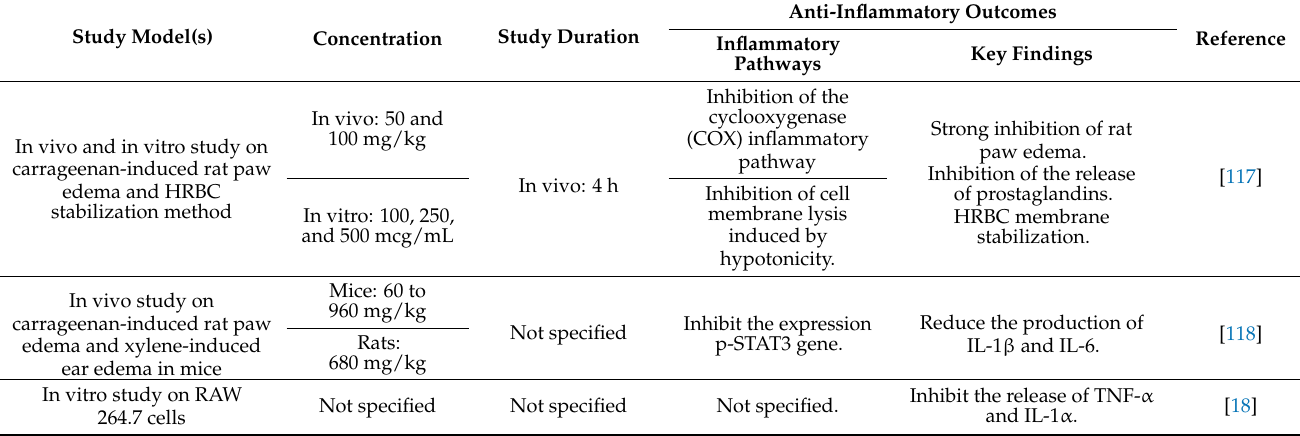
Table 5. Summary of studies proving the anti-inflammatory properties of agarwood